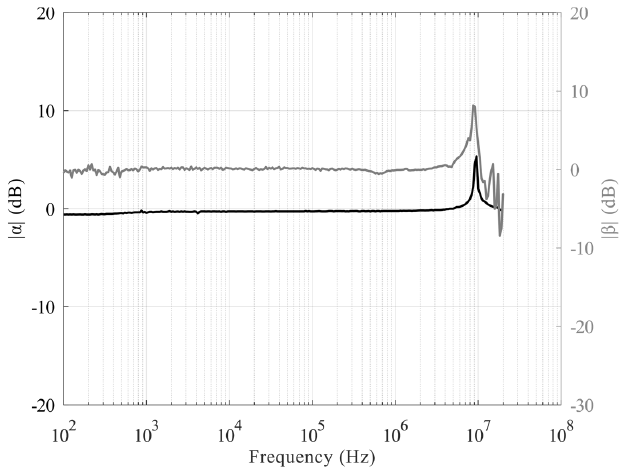
Figure 11. Measured transfer function in magnitude of both α (left axis) and β (right axis).